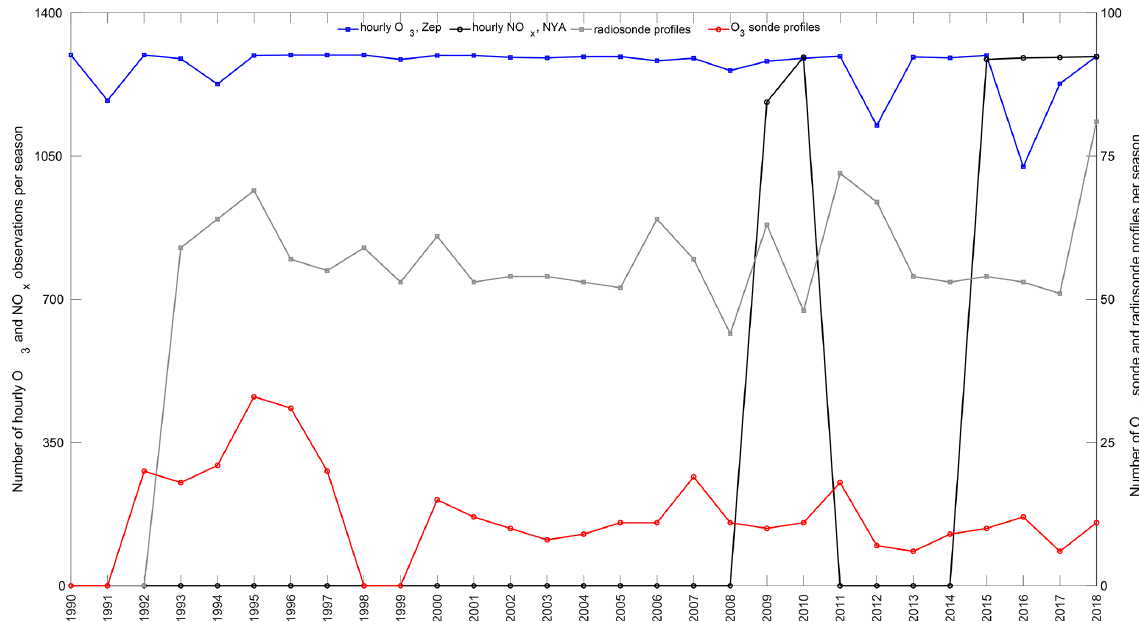
Figure A3. The O 3 and NO x hourly observations and O 3 sonde and radiosonde data availability chart for spring seasons 1990–2018.